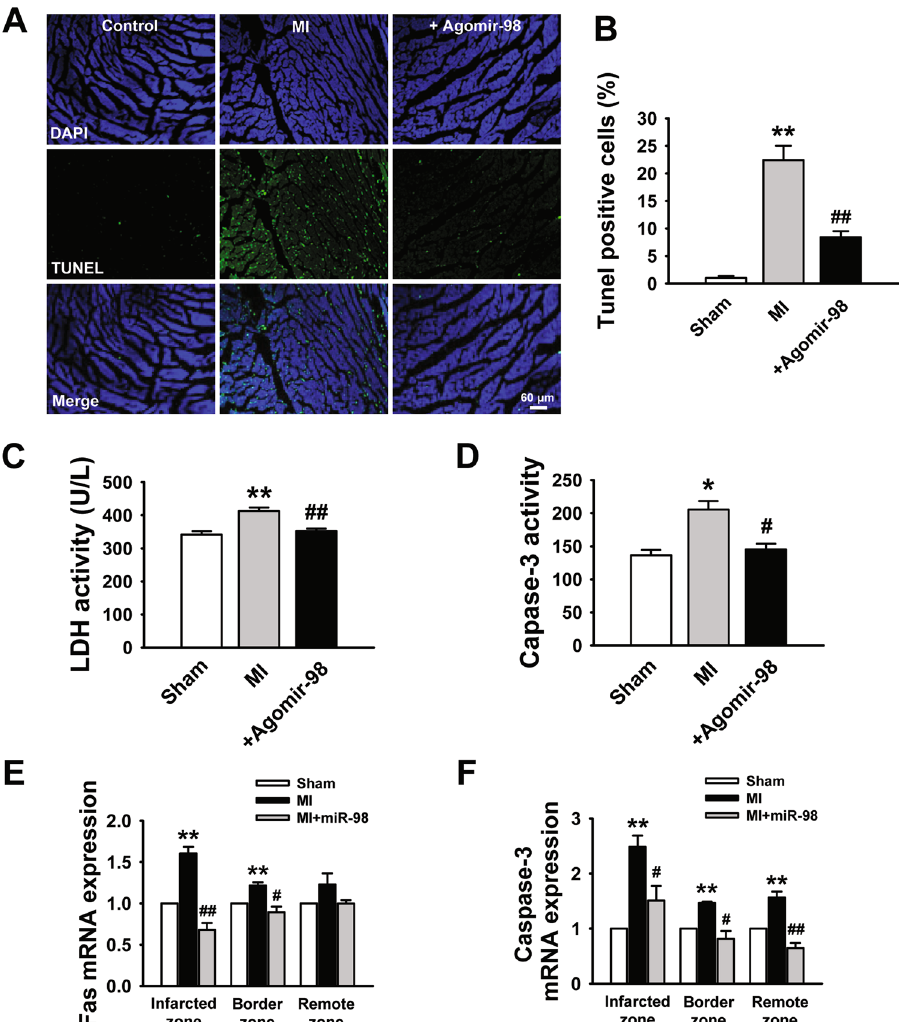
Figure 6. miR-98 protected cardiomyocytes against ischemia-induced apoptosis in a mouse MI model. ( A ) Effects of miR-98 agomir on cardiac apoptosis were evaluated by TUNEL staining. ( B ) The percentage of TUNEL-positive cell in different groups. n = 6. ( C ) Serum lactate dehydrogenase (LDH) activity is increased in MI mice and restored by miR-98 agomir administration. n = 6. ( D ) Caspase-3 activity is promoted in MI mice and reversed by miR-98 agomir. n = 5. ( E ) MiR-98 significantly prevented upregulation of Fas mRNA level in the infarcted and border zones of MI mice. n = 5. ( F ) MiR-98 suppressed the elevation of caspase-3 mRNA level in the infarcted, border and remote zones of MI mice. n = 5. * P < 0.05, ** P < 0.01 versus sham group; # P < 0.05, ## P < 0.01 versus MI